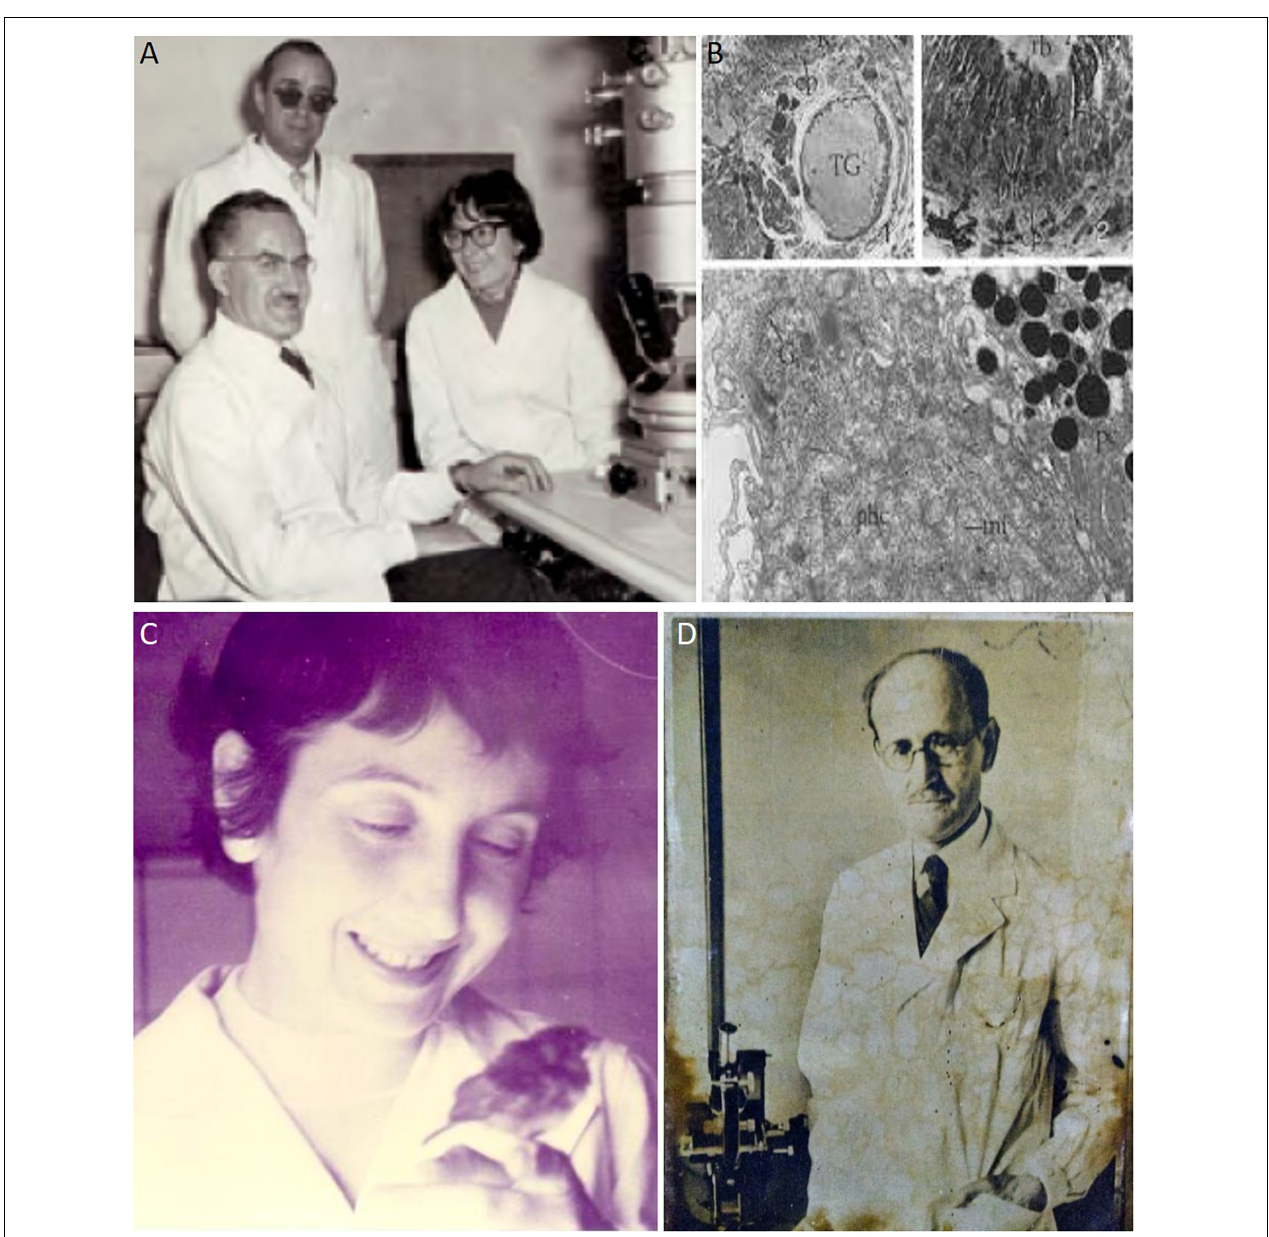
FIGURE 4 | Prof. Amanda Pellegrino de Iraldi. (A) Amanda Pellegrino de Iraldi in 1960 at Buenos Aires, together with Prof. Eduardo De Robertis (seated on the left) and Dr. Pedro Antonio Rodríguez-Pérez (on feet), commissioned by the Instituto Cajal (Spain) for the acquisition of an electron microscope like the one in the picture. (B) Images of synaptic vesicles isolated from nerve terminals taken at the electron microscope from sections of rat brain, originally published by De Robertis et al. (1962) in Nature. (C) Young Amanda Pellegrino de Iraldi admires a small bird in her hands. (D) Reproduction of the original portrait of Pío del Río-Hortega that Prof. Pellegrino de Iraldi had in her bureau. See the effects of time in the